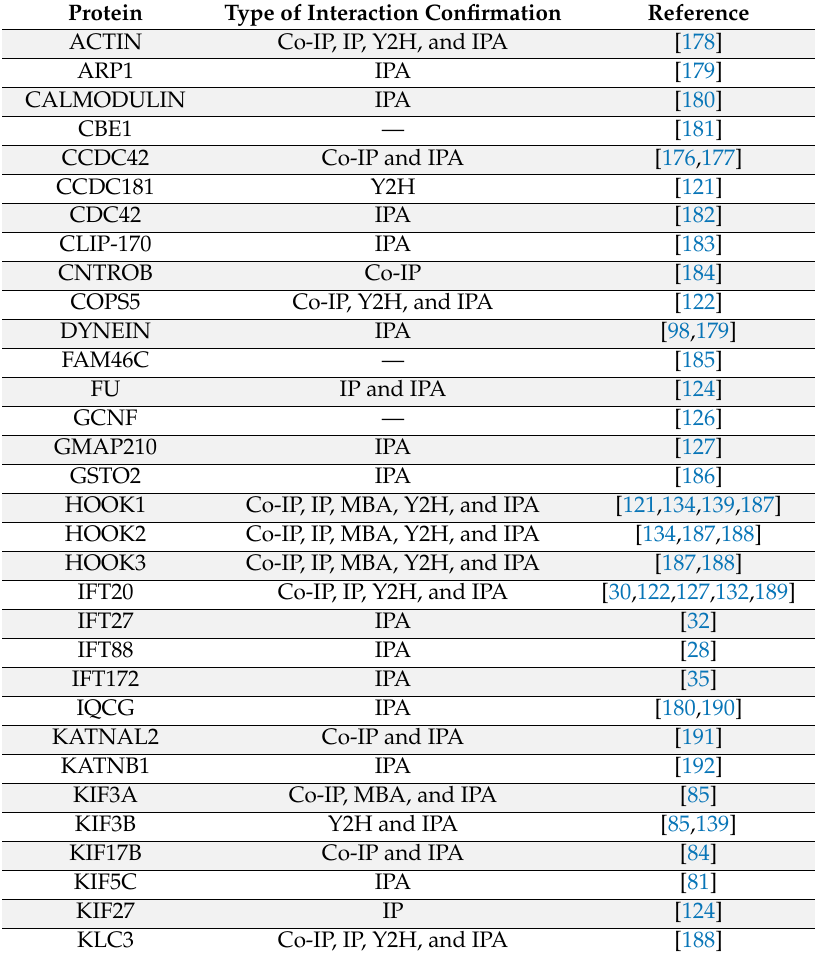
Table 4. List of proteins known to localize to the manchette and their interacting partners confirmed by binding assay (MBA), tubulin-binding assay (TBA) and / or IPA database (a ffi nity chromatography, co-IP, anti-bait co-IP, enzyme activity assay, in situ proximity ligation assay, IP, liquid chromatography mass spectrometry, pulldown assay, tandem a ffi nity purification, Western blotting, and yeast